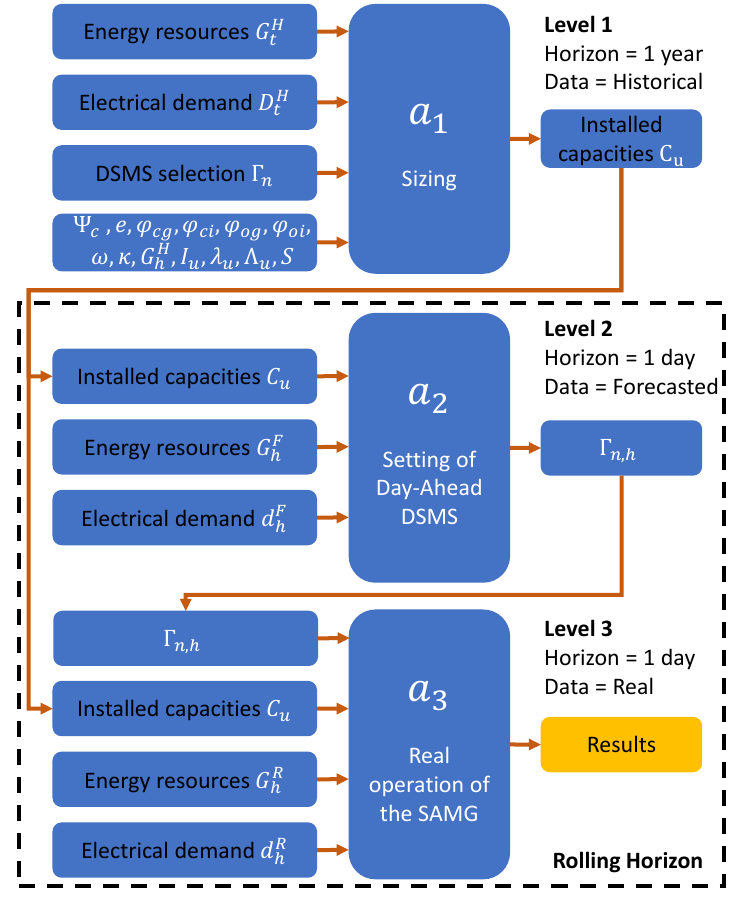
Figure 1. Graphical description of the proposed